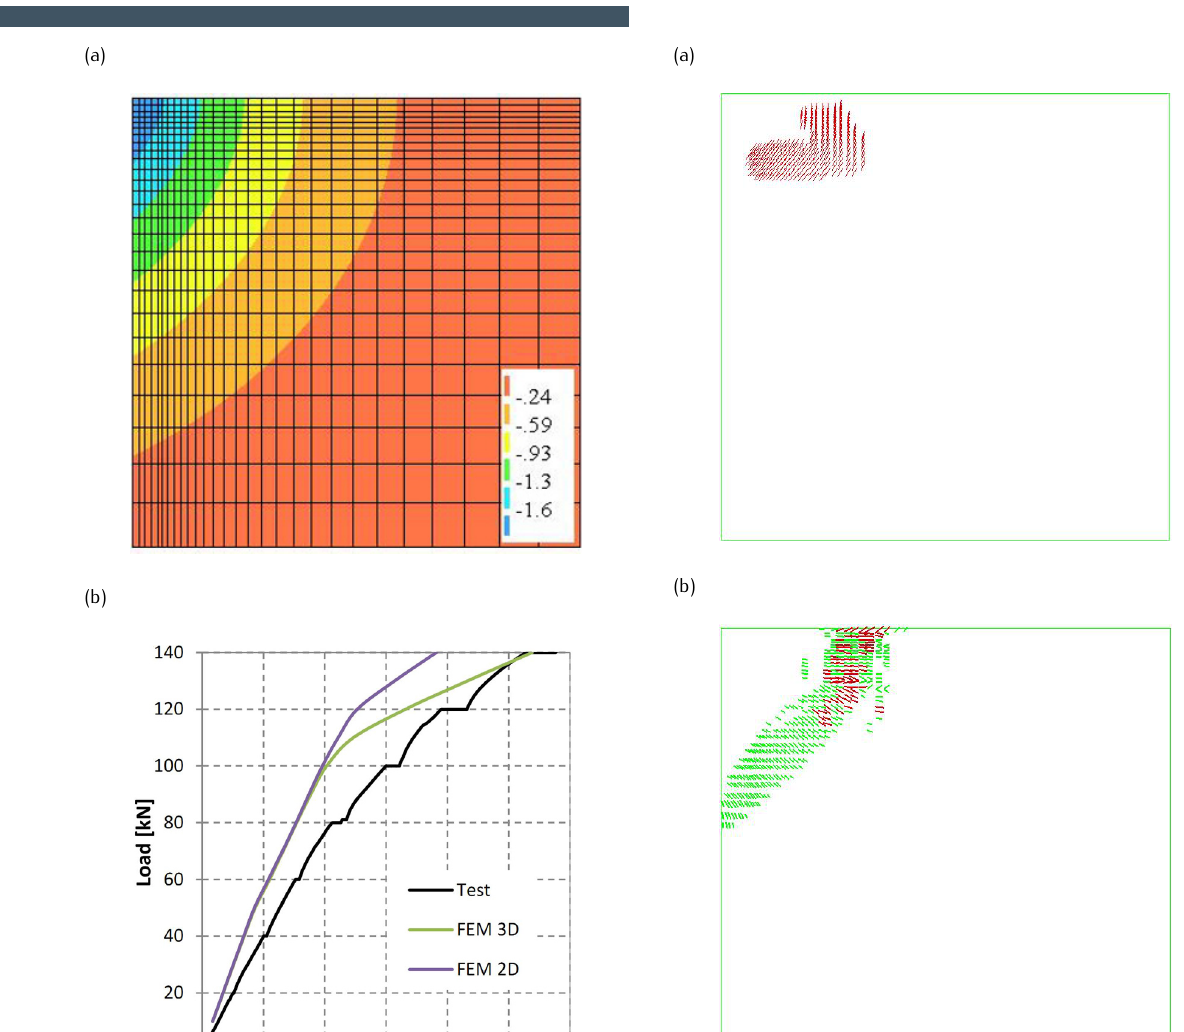
3D model is presented at load levels of 100 and 140 kN.